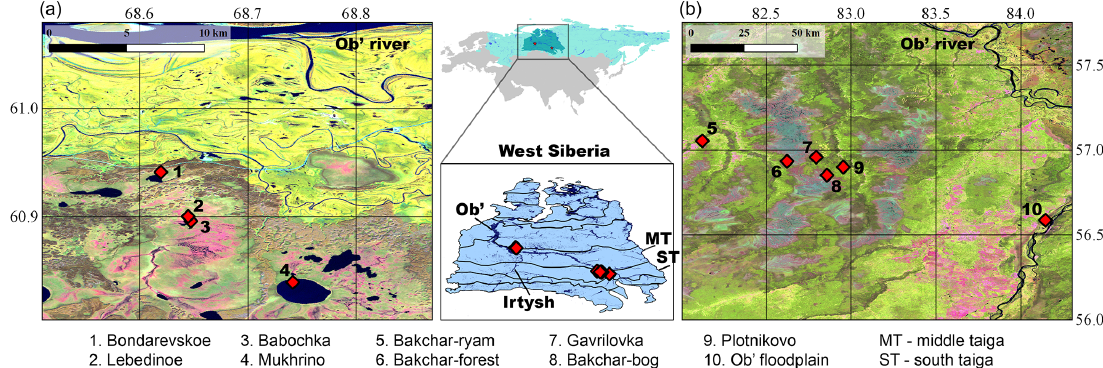
Figure 1. Studied lakes in MT ( a , shades of yellow correspond to floodplain, brown to forests, green to pine–shrub–sphagnum communities, purple to ridge–hollow complexes) and ST ( b , shades of green correspond to forests and grasslands, blue to wetlands) on Landsat satellite